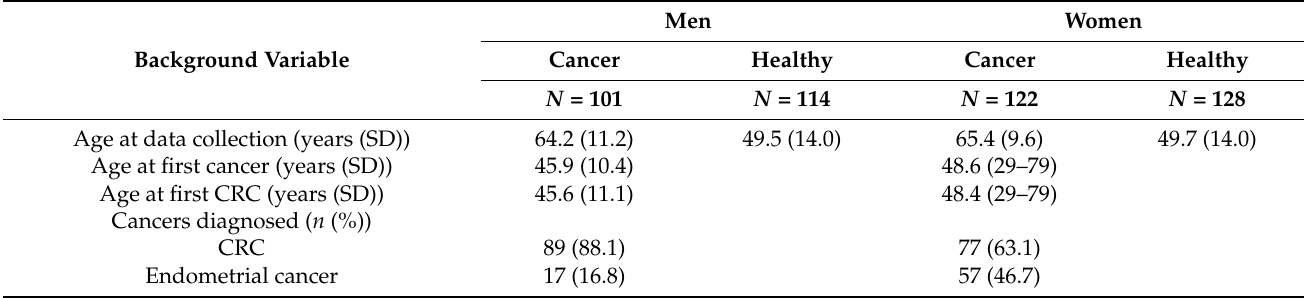
Table 1. Descriptive demographic, genetic, cancer history, socioeconomic, and lifestyle-related characteristics of the study